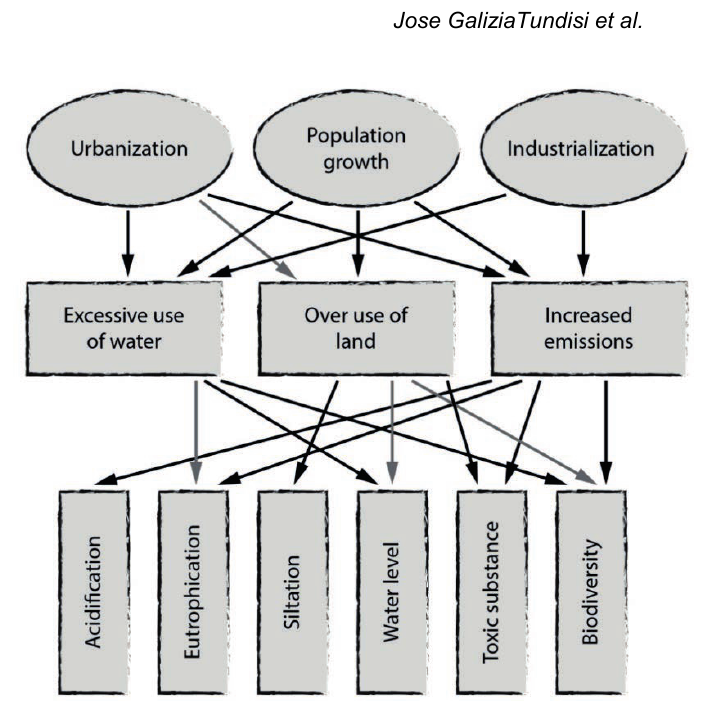
Fig. 3 Main causes of degradation of water quality. Based on a survey of 600 lakes and reservoirs in all continents. Source: ILEC